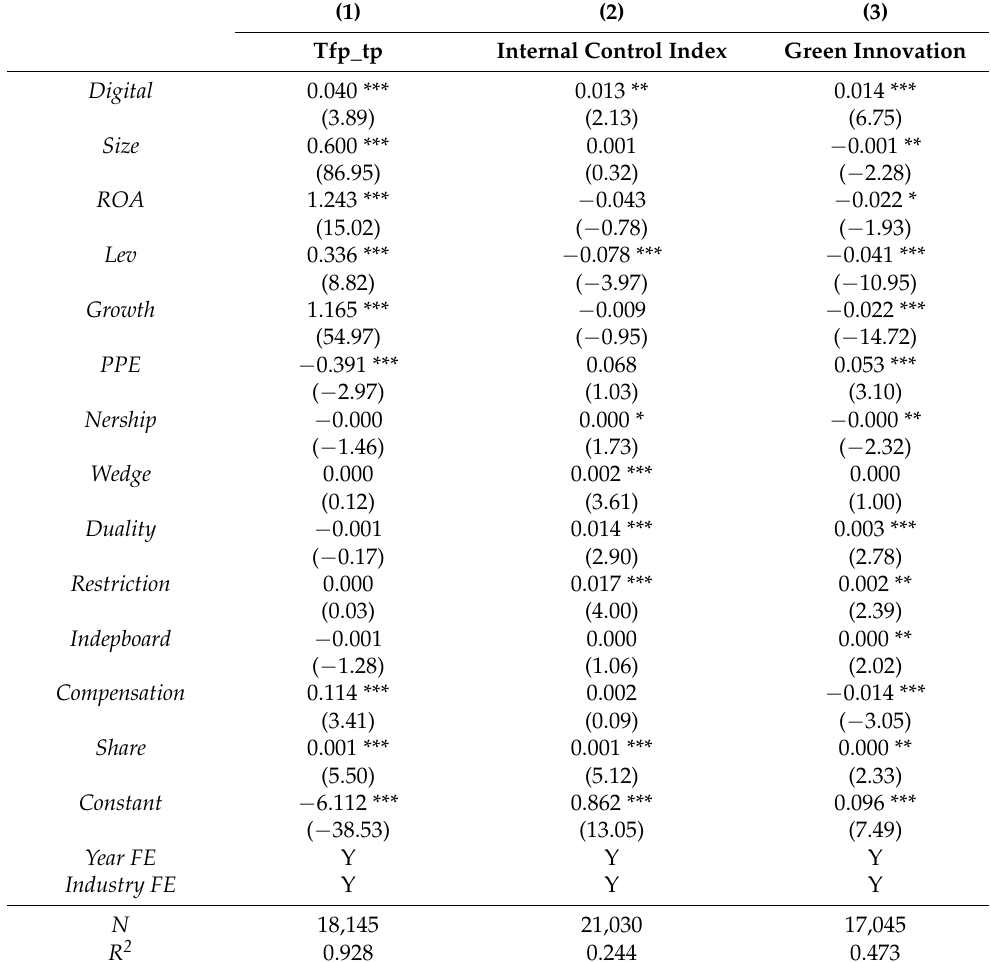
Table 5. Channel. This table reports the results of OLS regressions examining the effect of digital transformation on TFP, internal control index, and green innovation. Appendix A provides definitions of variables. The regressions control for one year and industry fixed effects. In parentheses are t -statistics based on standard errors adjusted for heteroskedasticity and firm